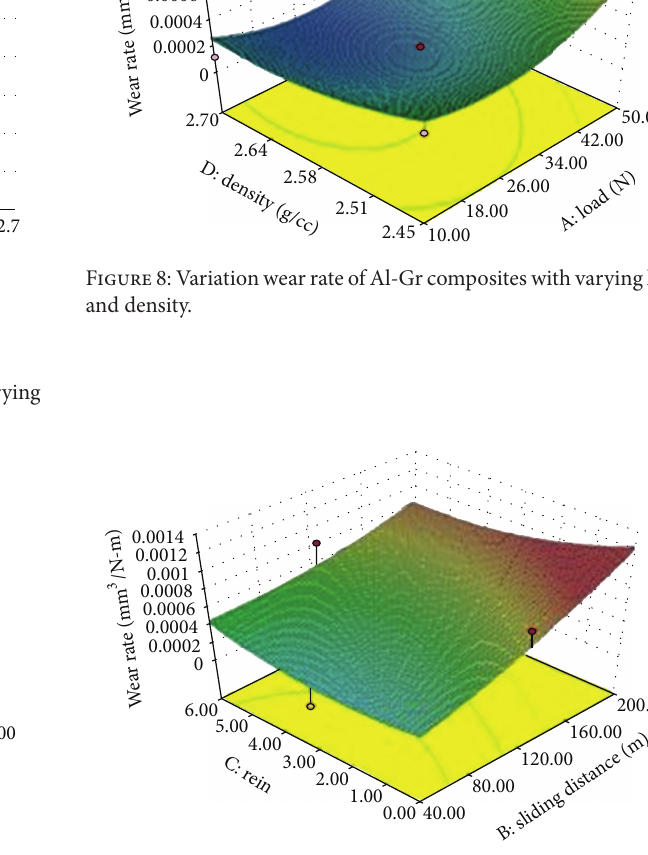
Figure 9: Variation of wear rate of Al-Gr composites with distance and graphite